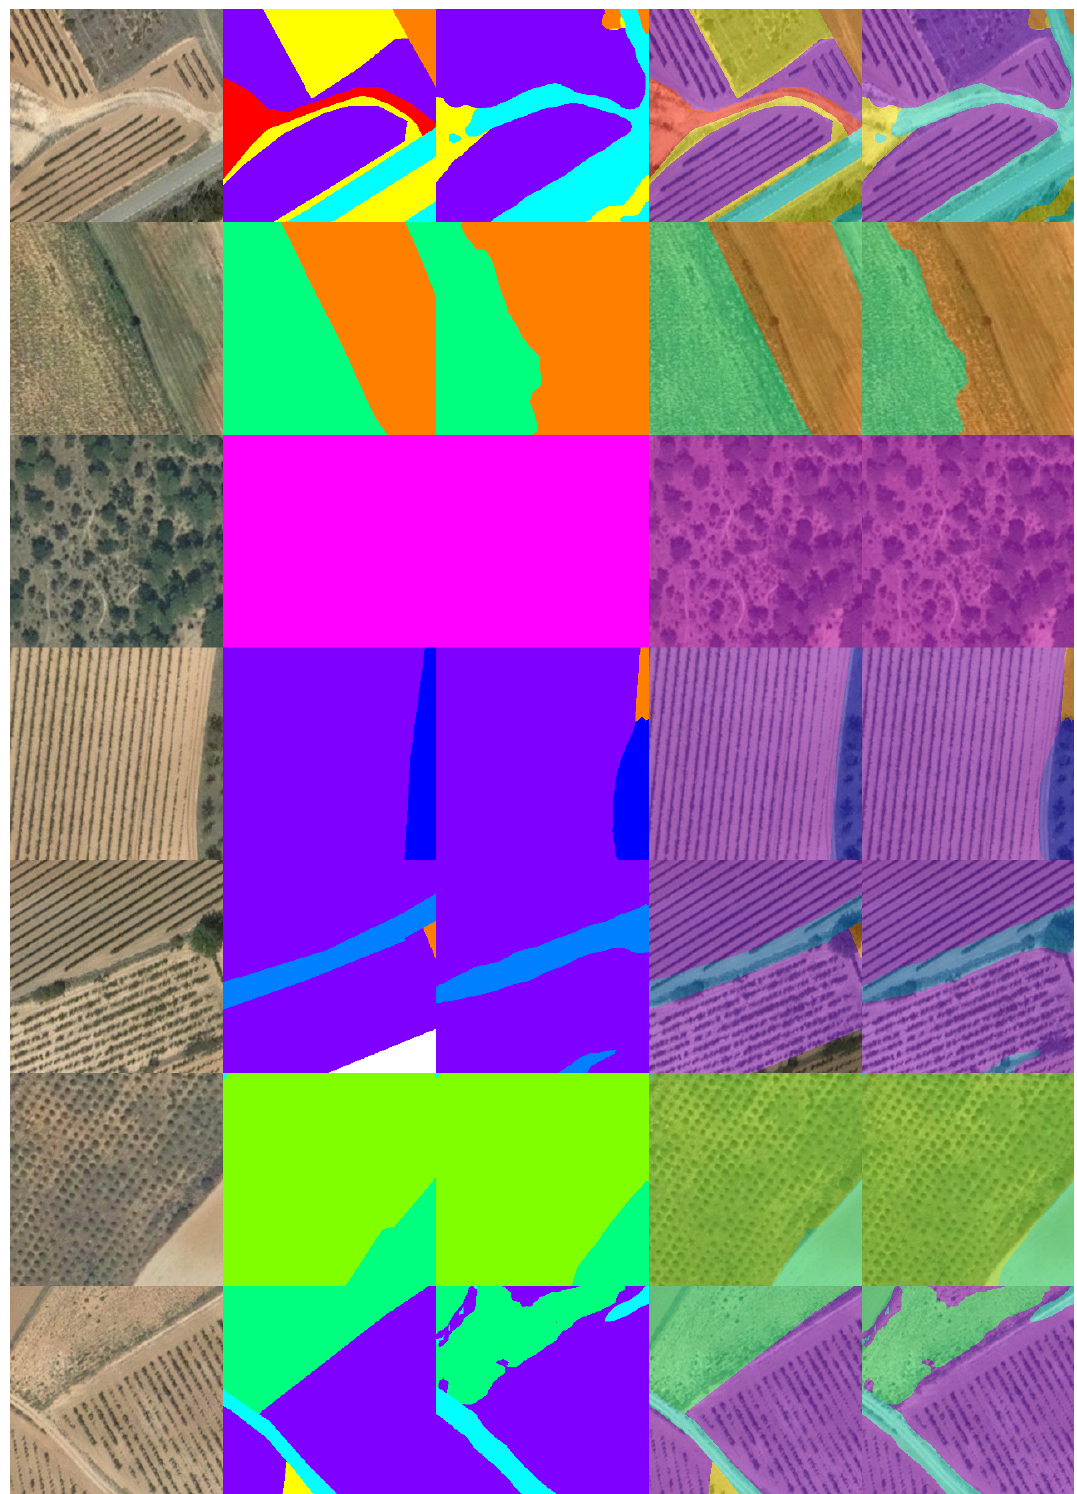
Figure 8. Visualization of the predicted results for DeepLabV3+ evaluated in UOPNOA (Experiment Base). ( 1st col. ) Original images, ( 2nd col. ) ground truth masks, ( 3rd col. ) predictions, ( 4th col. ) overlapping of original images with ground truth masks, ( 5th col. ) overlapping of original images with